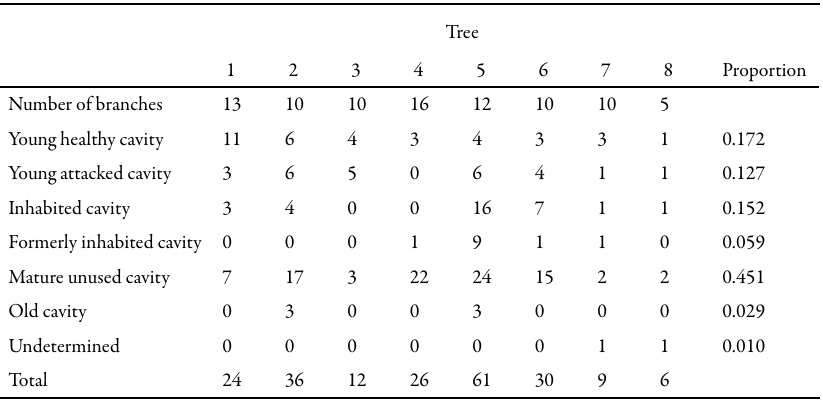
table 1. Cavity data per tree. Cavity types are defined according to Fig. 1. The two undetermined cavities correspond to cavities that were damaged during sampling. All trees located in taipei, except for tree 7 located at Bitou Cape and tree 8 located at